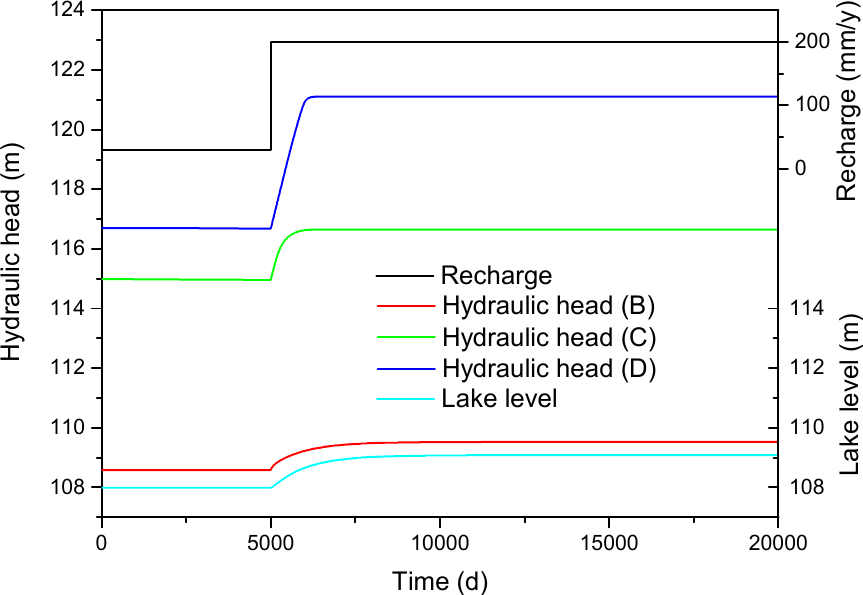
Figure 6. Time series of climatic variable (represented by recharge rate), lake stage and hydraulic head. The locations B (at lake), C (midway to basin boundary), and D (at basin boundary) are depicted in Figure